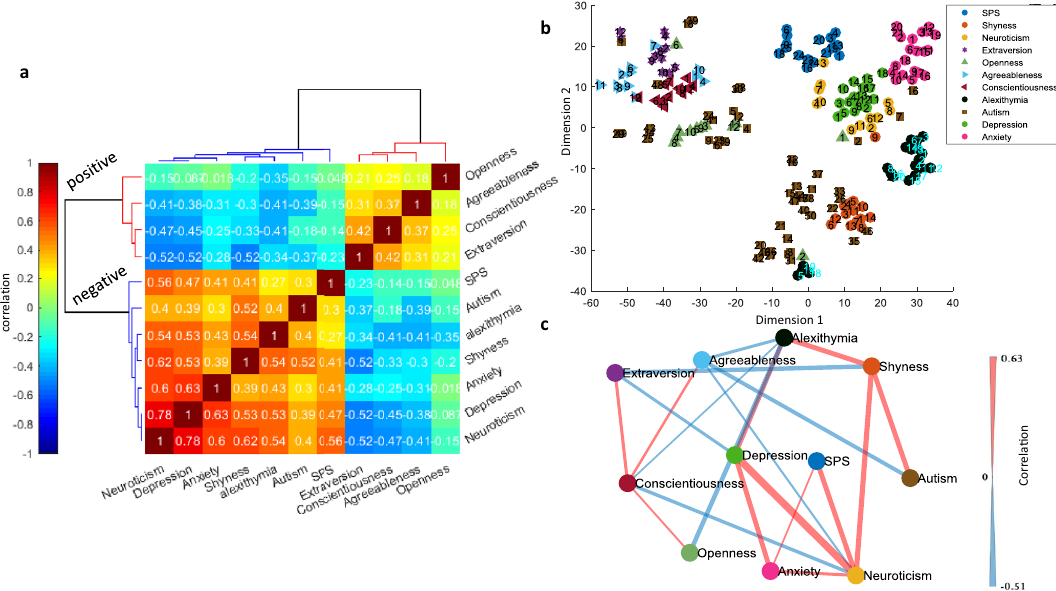
Figure 4. Modified 16-question version of HSPS shows better localization in the trait space. ( a , b ) same format as Figs. 2a and 3b, respectively but for the modified version of the HSPS questionnaire with AES component mostly removed. ( c ) same format as Fig. 2b but for the SPS score based on the modified HSPS